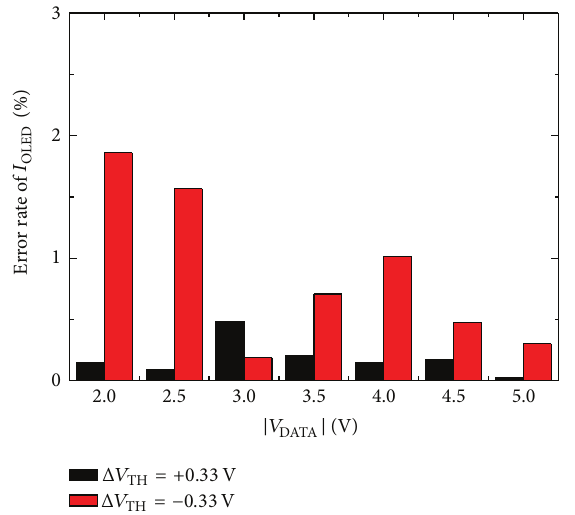
at different 𝑉 with threshold OLED DATA = −0.33 and +0.33 V); the average error TH